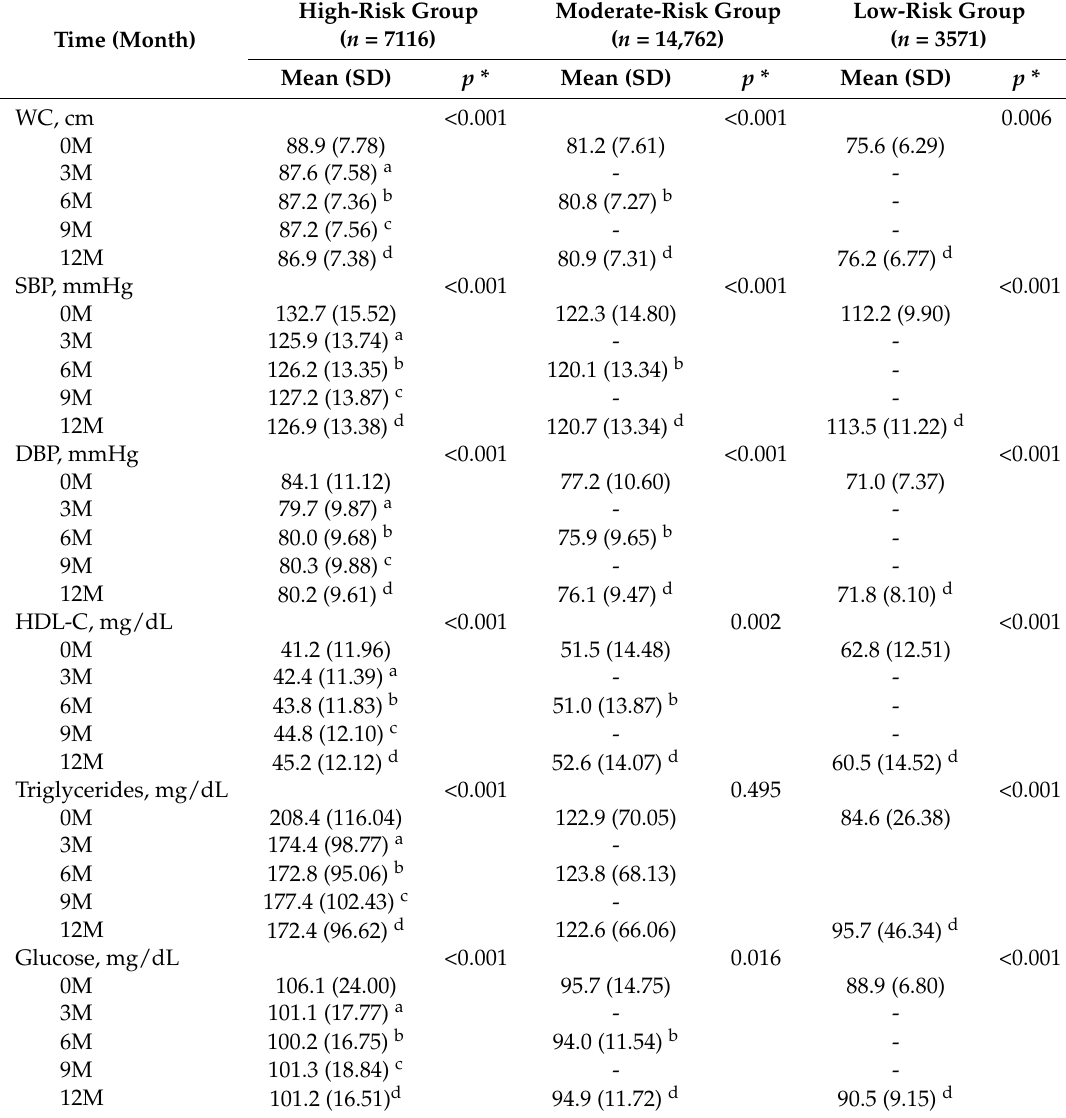
Table 2. Changes in risk factors of metabolic syndrome over the SMESY intervention ( N = 25,449).